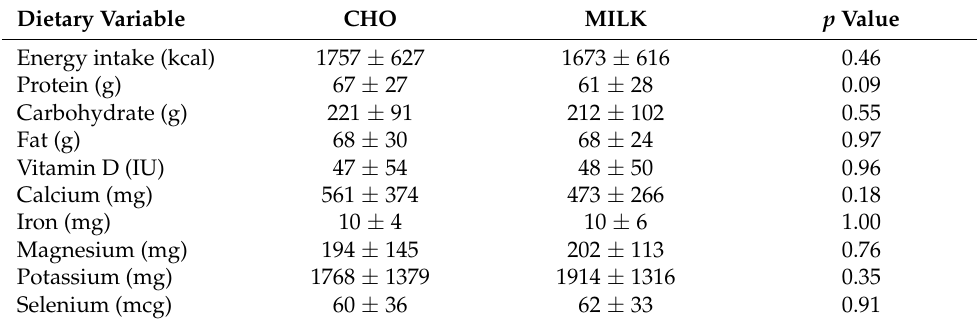
Table 1. Average daily dietary intake during the MILK and CHO trials, based on analysis of 2-day food records (day of exercise and day post-exercise) excluding the nutrient information from the provided trial drinks.